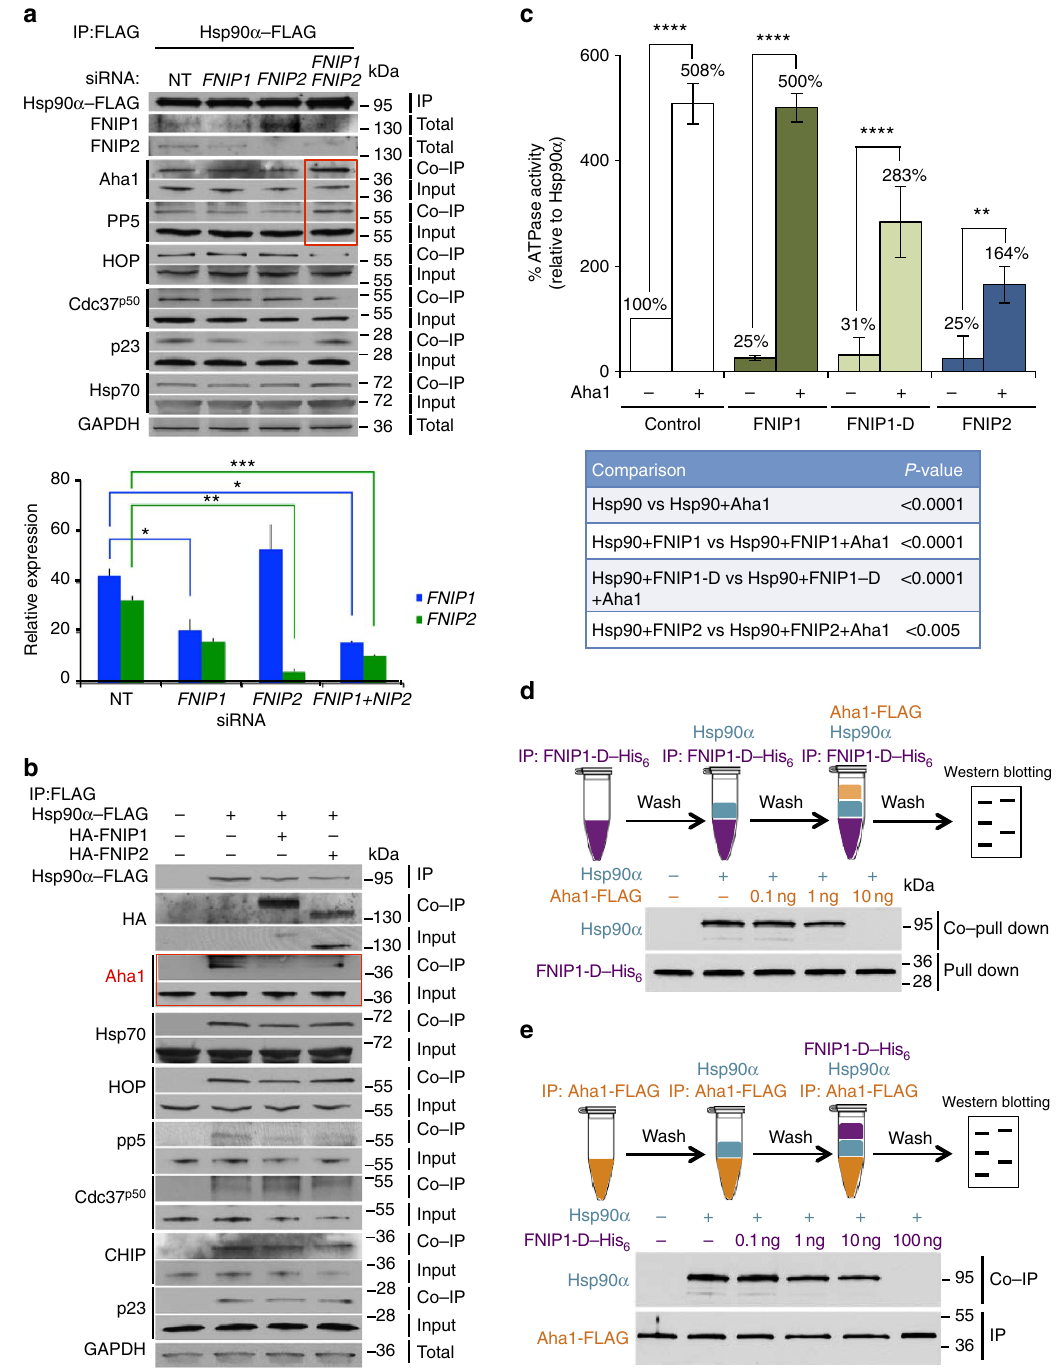
Figure 6 | FNIPs compete with the Aha1 co-chaperone for binding to Hsp90. ( a ) Hsp90 a –FLAG was transiently expressed in HEK293 cells for